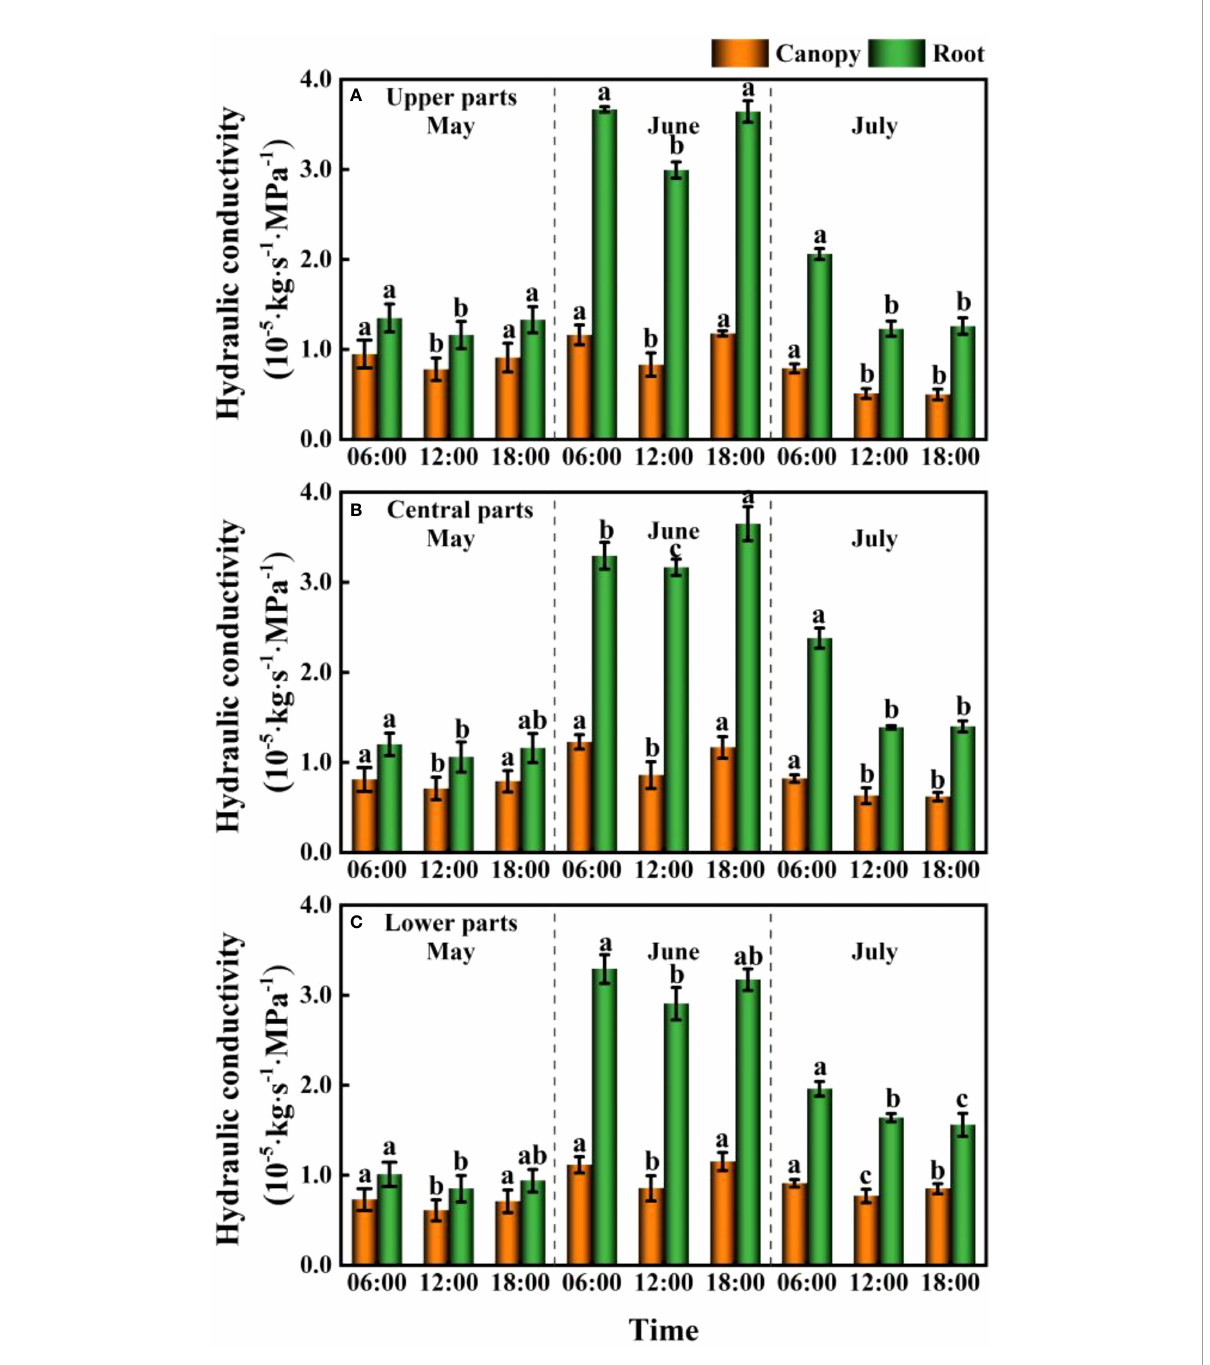
FIGURE 8 Daily and seasonal variations in the canopy and root hydraulic conductivity for Ferula bungeana growing on mega-dunes in the Badain Jaran Desert during the 2020 growth season. (A – C) present data for the upper, central, and lower parts of mega-dunes, respectively. Data are presented as the means ± 1SE. Different lowercase letters indicate signi fi cant differences in hydraulic conductivity at different times within a single sampling day at the P < 0.05 level of signi fi